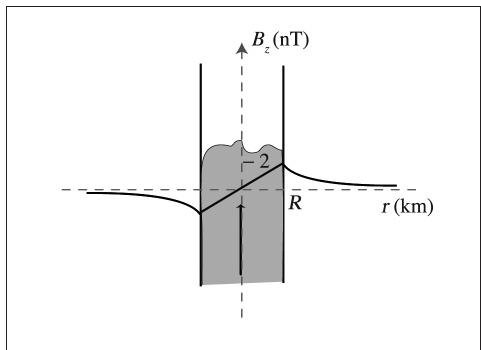
Fig. 2. The magnetic field B z induced by the lifting flow of magma. R is the radius of the channel or magma